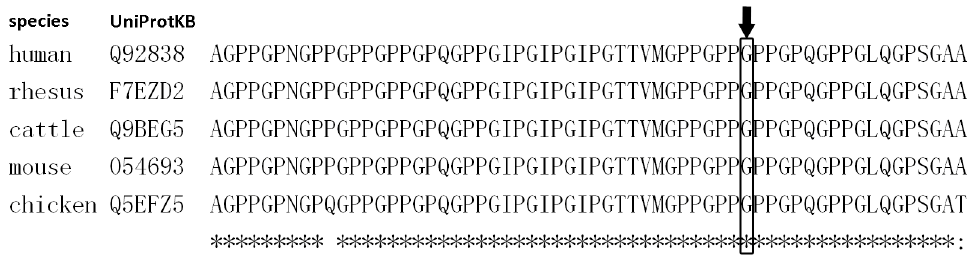
Figure 4. A cross ‐ species alignment of the amino acid sequence of EDA indicated that p.Gly221 (in the box) was conserved.